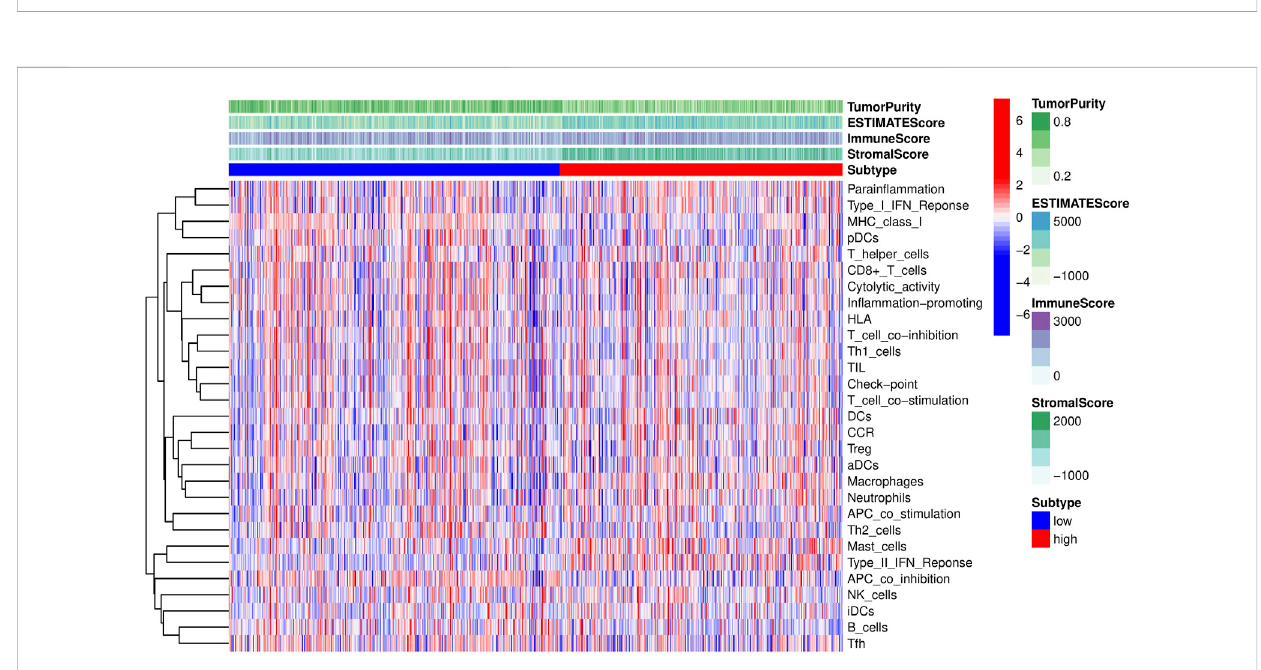
FIGURE 12 Heatmap revealing the scores of immune cells in the high-risk and low-risk